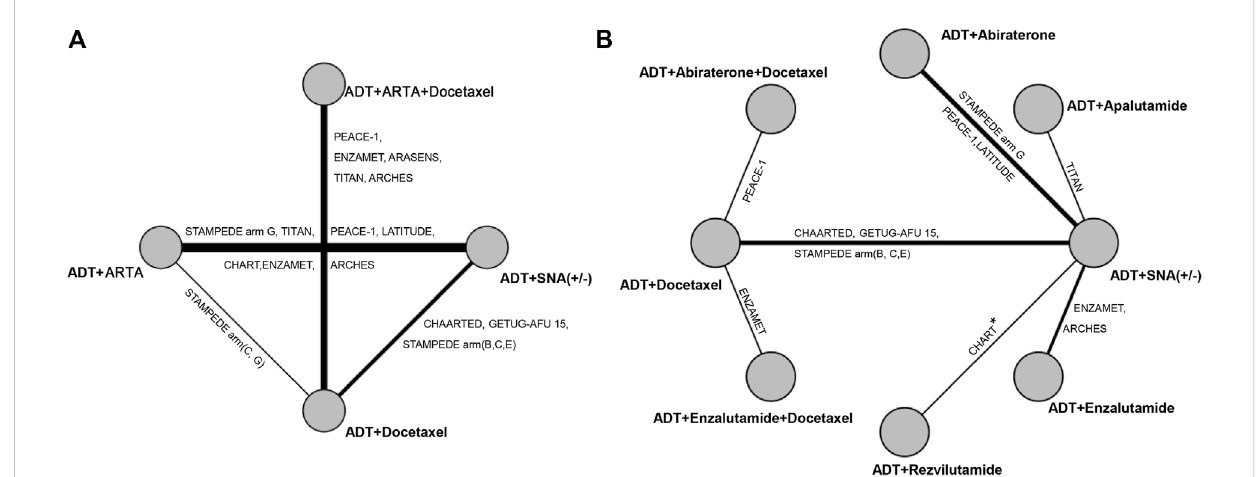
FIGURE 2 Network graph of trials comparison. (A) Comparison for categorized therapies. (B) Comparison for speci fi c therapies in high- and low-volume disease. The nodes (circles) represent comparative therapy, and the edges (lines) show which therapies have been compared. The labels on the edges represent the names of RCTs comparing therapies. * Present at high-volume rather than at low-volume. RCTs, randomized controlled